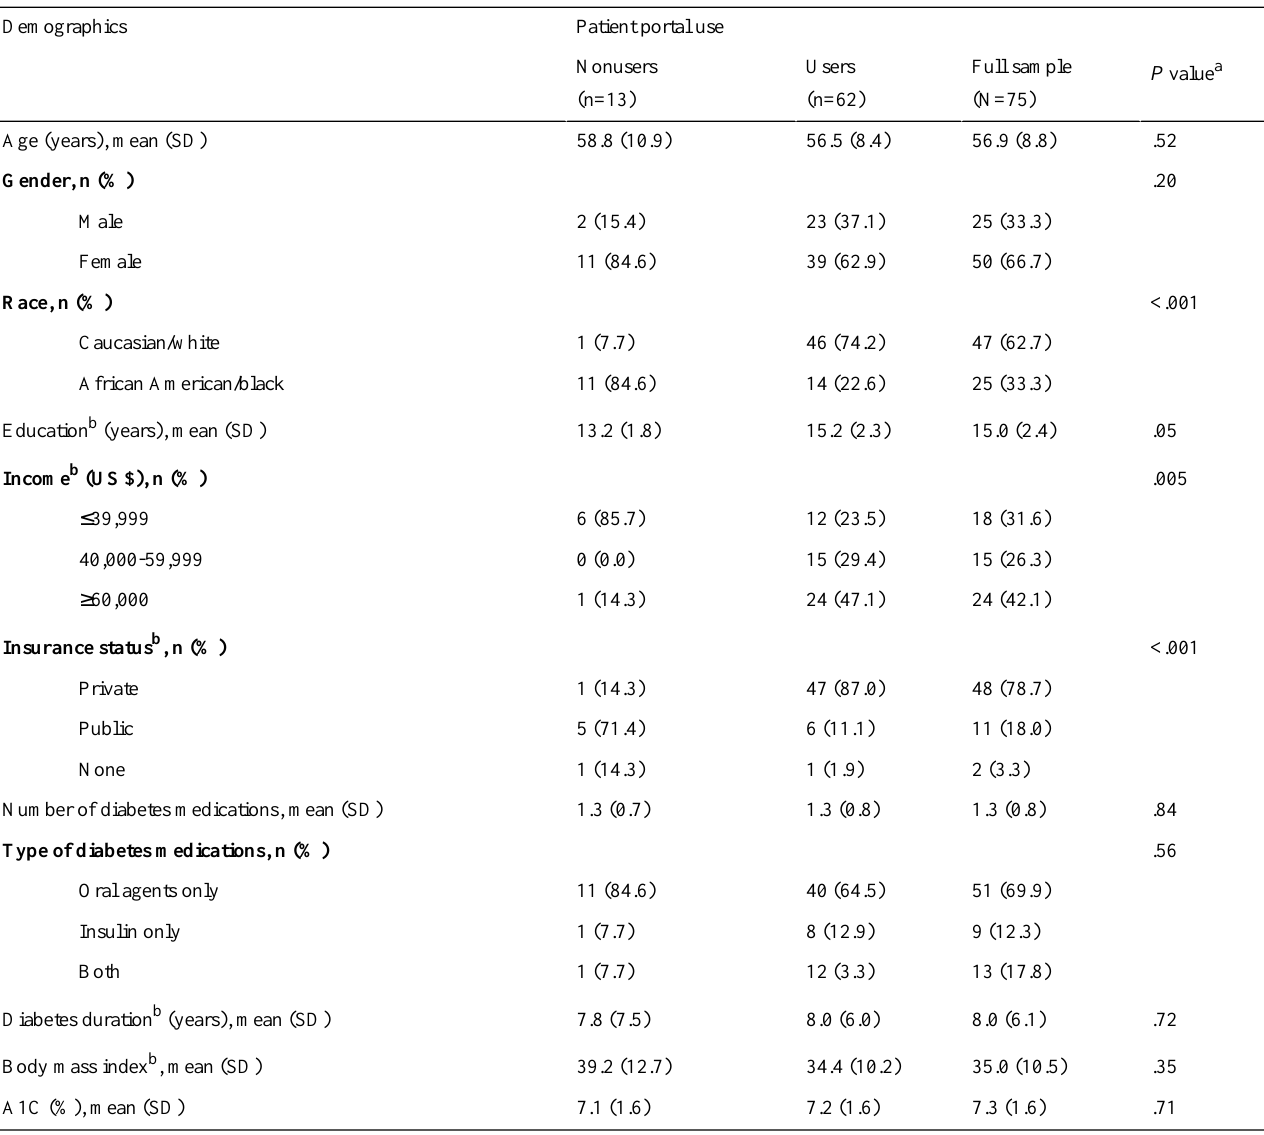
Table 1. Participant demographic and clinical characteristics stratified by patient portal